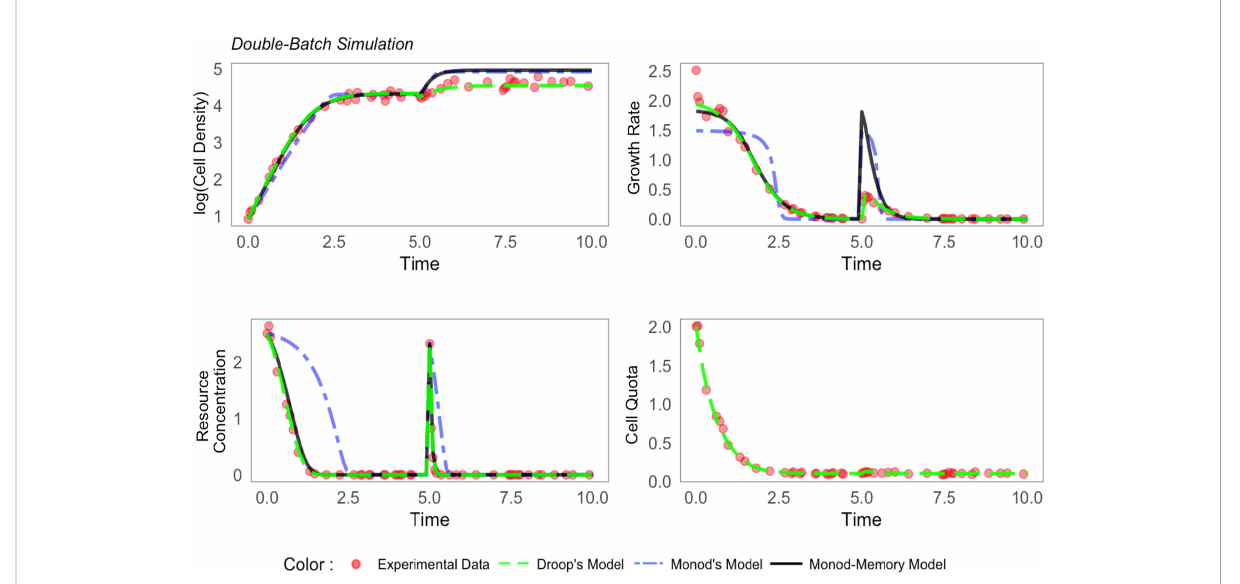
FIGURE 1 Comparison of simulated population dynamics with resupplied nutrients at time t = 5. Parameters are chosen from Table